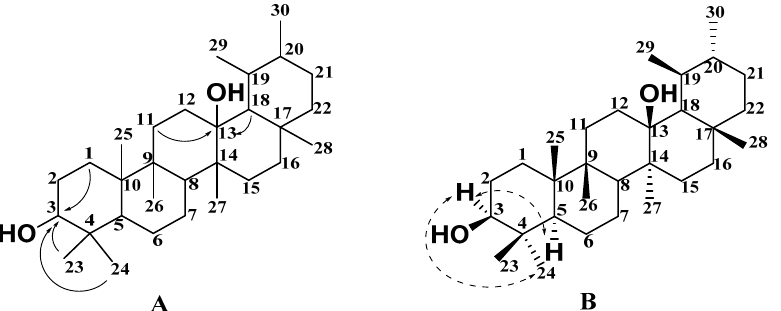
Figure 5. Key HMBC (plain arrow; A ) and NOESY (dash arrow; B ) correlations of compound 9 .